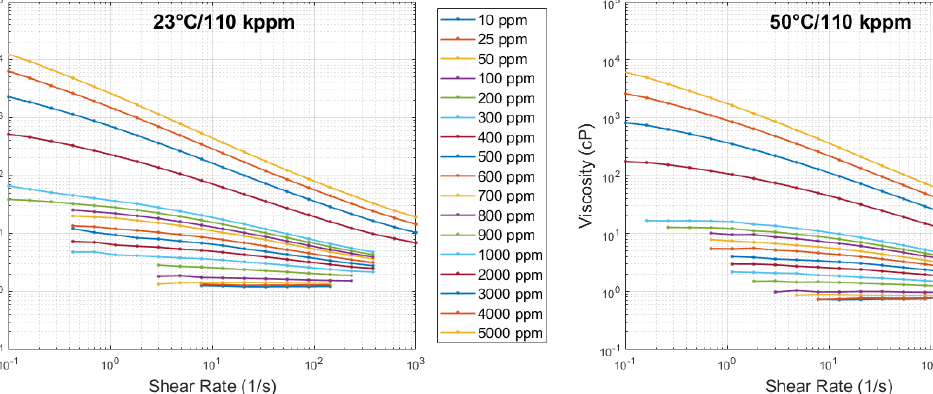
Figure 7: Flow curves graph at 50 ∘ C and 110,000 ppm of NaCl